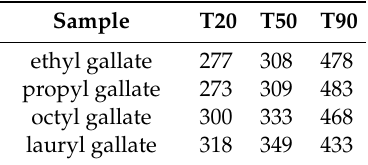
Table 1. T20, T50, and T90 of the examined gallates.